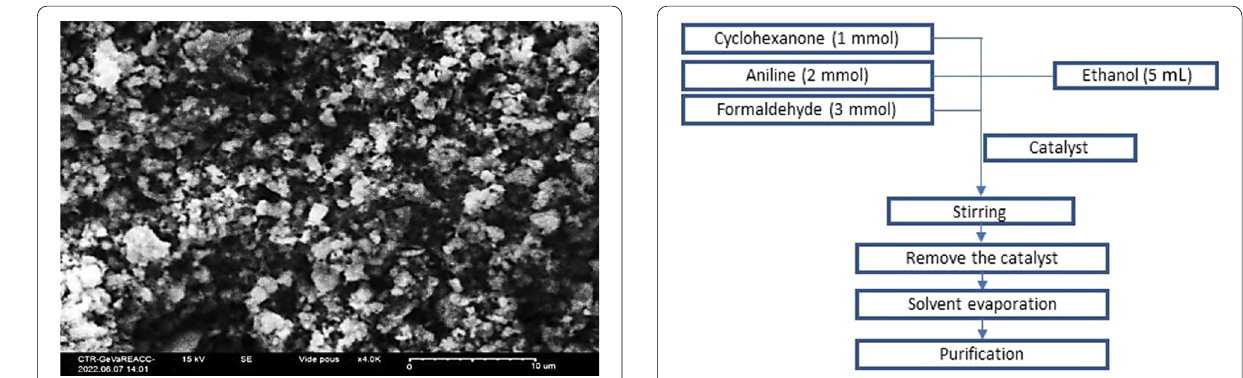
Fig. 3 Spiropyrimidine synthesis reaction procedure